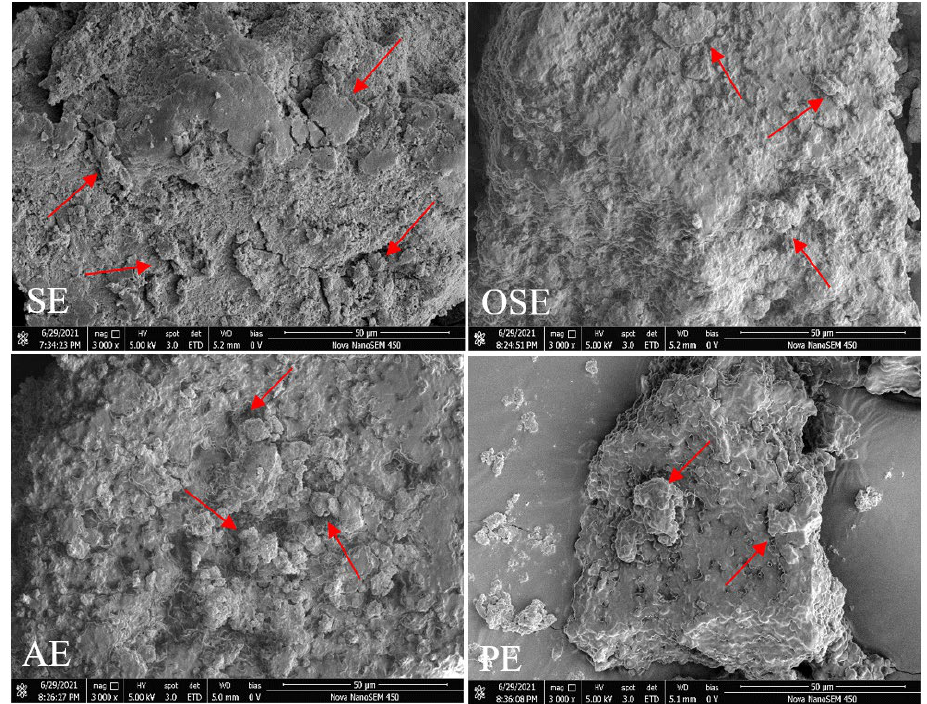
Figure 1. SEM images of field muskmelon seeds protein extracted by different oil extraction methods.